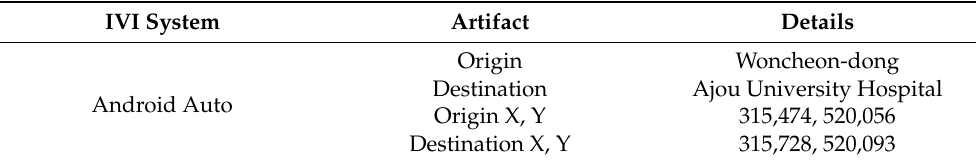
Table 3. List of Artifacts in Wireless Communication between the Cloud and Mobile Device. IVI